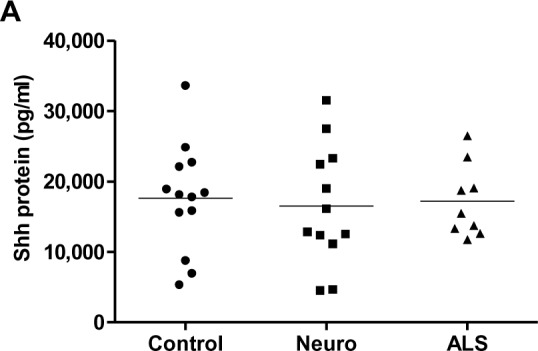
Direct measurement of Shh in CSF reveals comparable protein levels in ALS patients and controls.(A) Shh protein concentrations (pg/ml) in CSF samples are shown in normal controls (Control), neurological controls (Neuro), and patients with ALS (ALS). Protein concentrations were measured by commercial ELISA kit as described in Materials and Methods. Standard was prepared as per manufacturer’s protocol, and Shh protein levels were quantified based on standard curves obtained using ELISA reader. Detected Shh concentrations were17,195 ± 5,155 pg/ml in the ALS group, 17,624 ± 7,676 pg/ml in normal controls, and 16,480 ± 8,495 pg/ml in neurological controls that were not significantly different (p = 0.89, normal controls versus ALS).